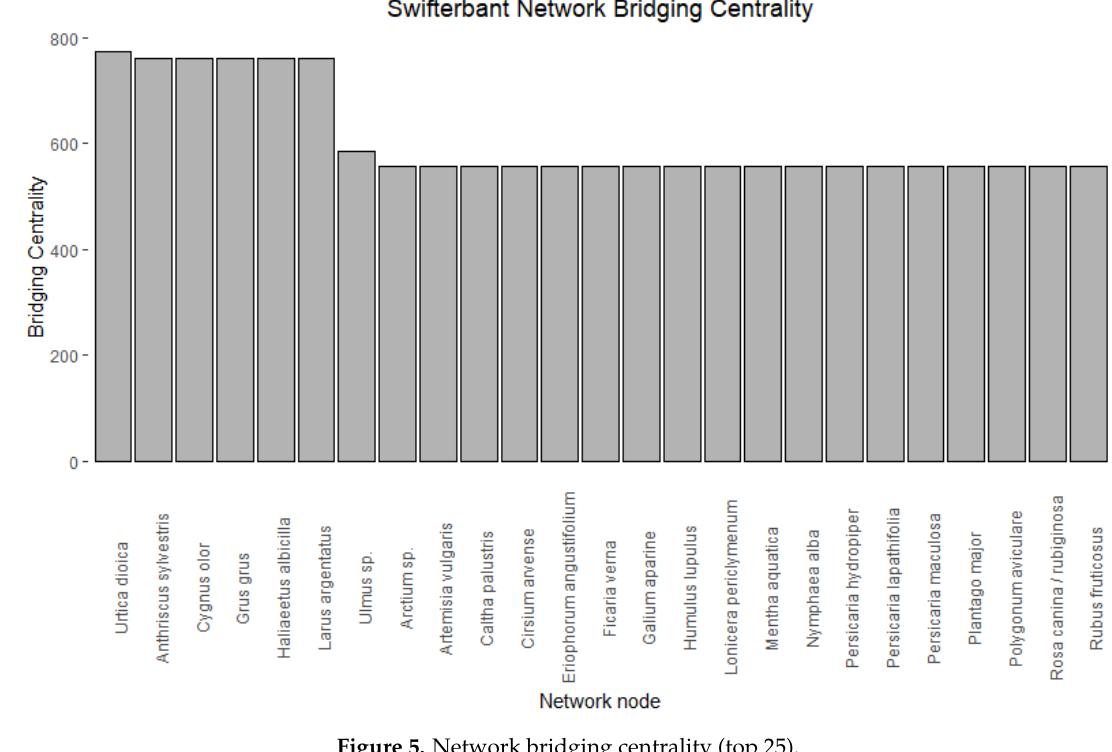
11 of 21 Figure 4. Network betweenness (top 25).